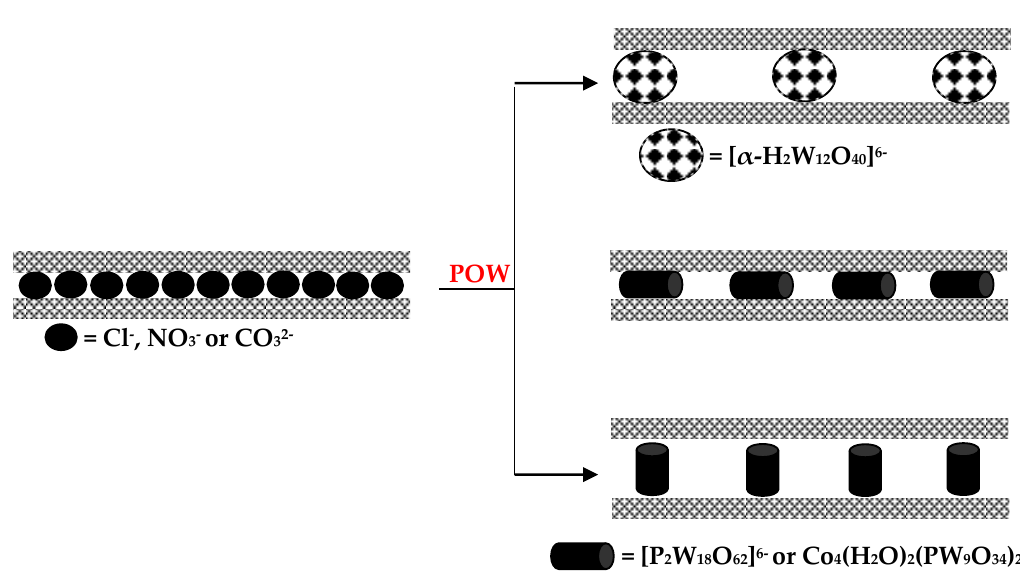
Figure 11. Schematic representation of LDH pillared by Keggin POW ions with nearly spherical symmetry and by Dawson and Finke POW ions with cylindrical symmetry. Adapted from Ref. [97], Copyright 1996, American Chemical Society.